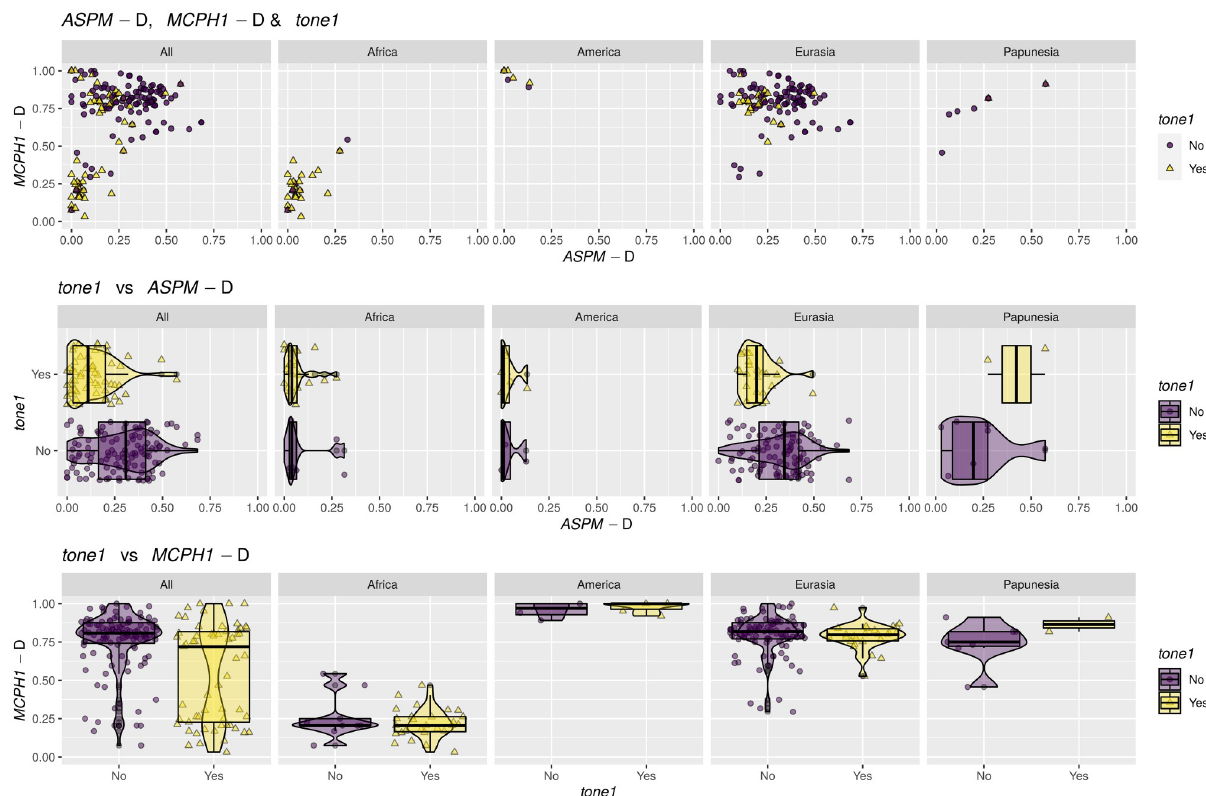
Fig 8. Relationship between tone1 (colour & shape) and the population frequency of ASPM -D and MCPH1 -D in the whole database and separately by macroarea (columns). Top row: scatter plots of ASPM -D (horizontal axis) and MCPH1 -D (vertical axis) versus tone1 (dot colour & shape). Next two rows show the “derived” allele frequency (as actual jittered observations, violin plots and boxplots) versus tone1 values (color) for ASPM -D (middle row) and MCPH1 -D (bottom row); please note that the orientation of the axis showing the “derived” allele frequency is the same as in the top row plots (i.e., x-axis for ASPM -D, and y-axis for MCPH1